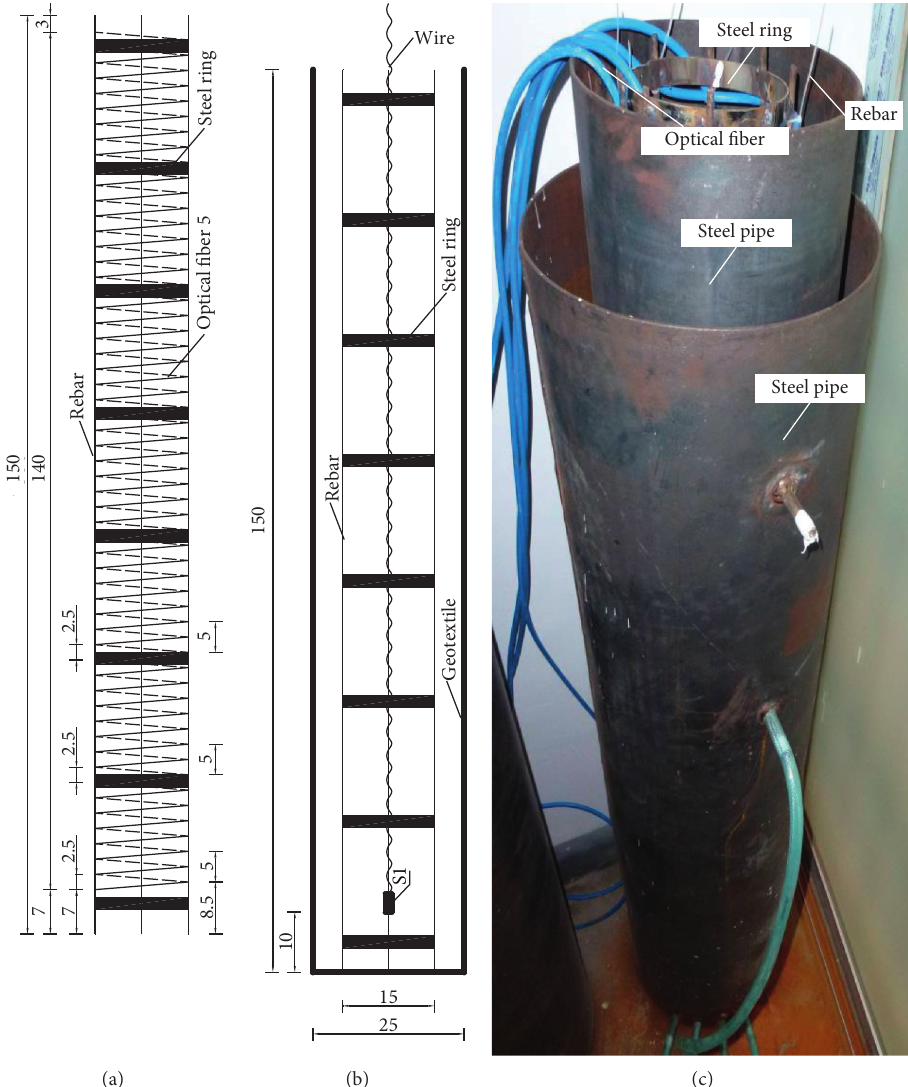
Figure 2: One-dimensional cylinder model and cable dispersion around design (unit: